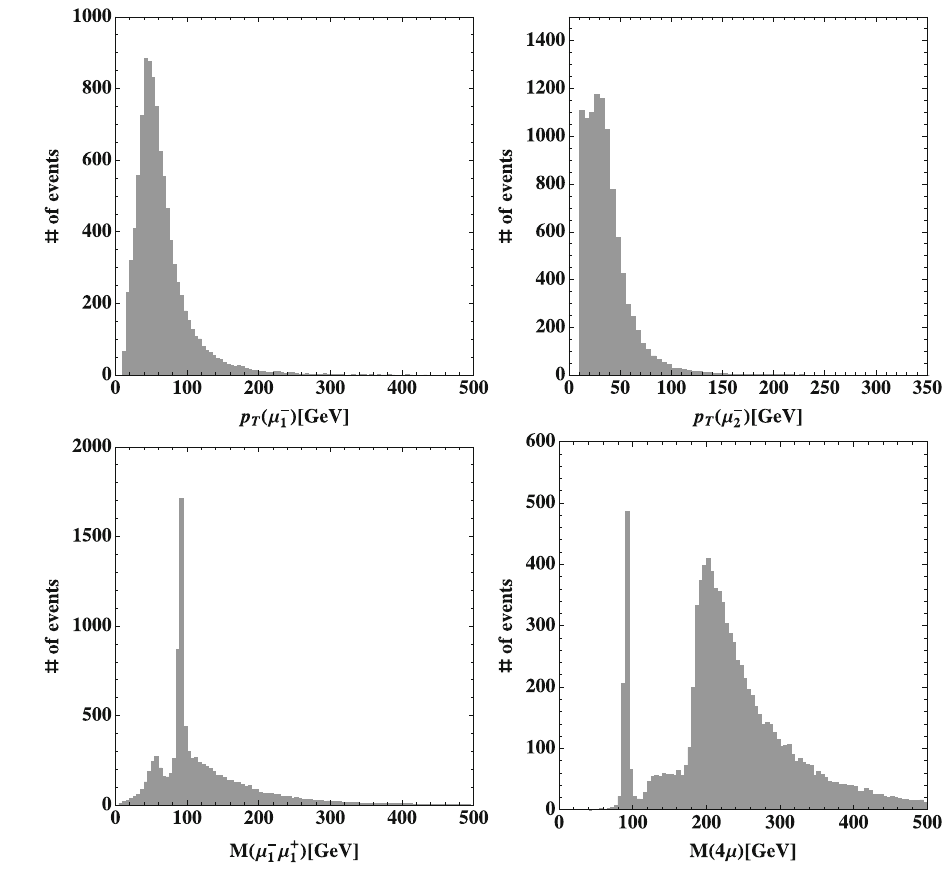
Fig. 7 Kinetic distributions of final state muons for